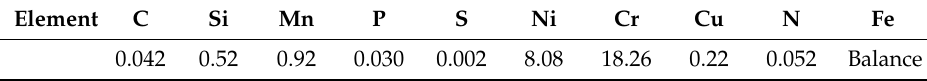
Figure 1. ( a ) Initial grain structure of the sample, ( b ) shape of the tensile coupon, and ( c ) image of the coupon fixed on the deformation-testing machine. Table 1. Chemical composition of the tested steel (mass%). Table 1. Chemical composition of the tested steel (mass%).